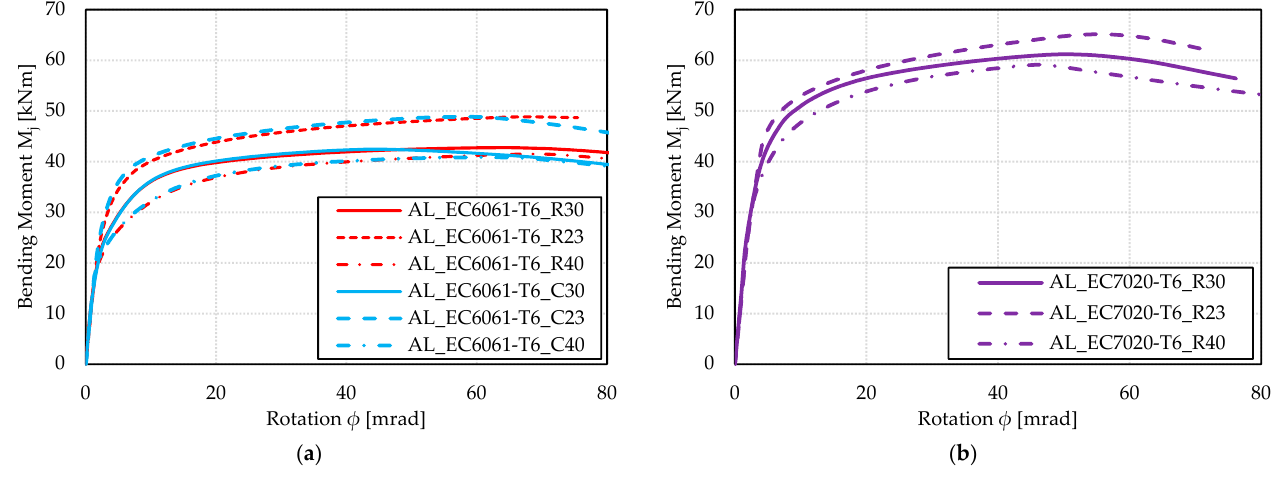
Figure 15. Moment–rotation curves for models with the effect of different assumption of the HAZ extent for alloys: ( a ) EN AW-6061-T6; ( b ) EN AW-7020-T6.